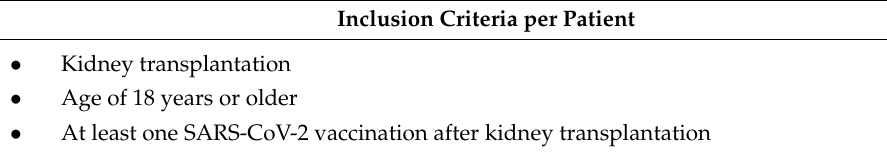
Table 1. Inclusion and exclusion criteria. Since main data analysis was performed at the vaccina- tion level, all SARS-CoV-2 vaccinations for patients meeting the inclusion criteria were included, while vaccinations were excluded based on the exclusion